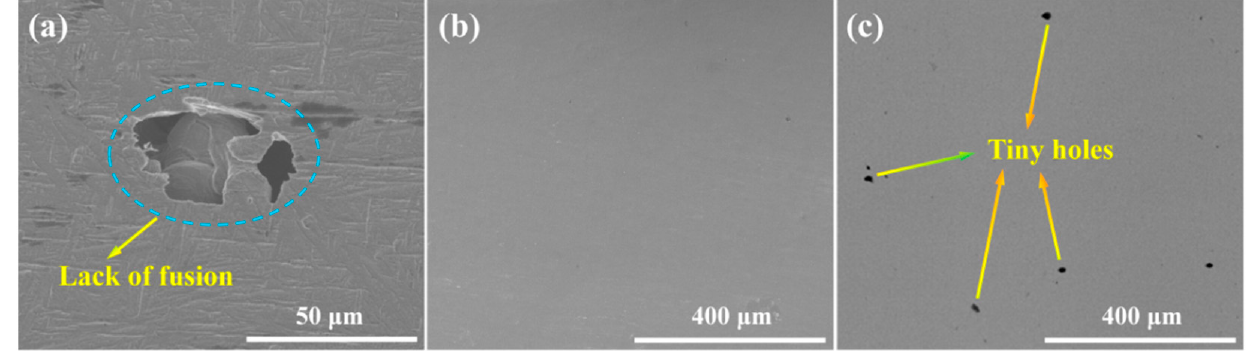
Figure 9. Various types of defects present across the as-LPBFed TA15 titanium alloy at different energy densities: ( a ) 48.48 J/mm 3 , ( b ) 100 J/mm 3 , and ( c ) 117.28 J/mm 3 .